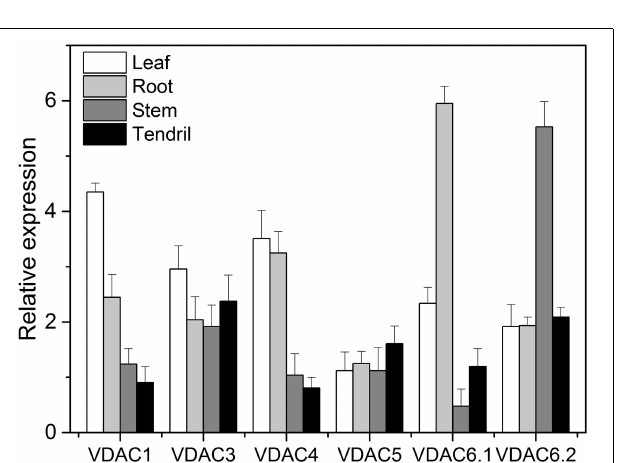
FIGURE 4 | VpVDACs expression in grape tissues. Relative VpVDAC expression in the leaves, roots, stems, and tendrils of “Liuba-8” ( V. piasezkii ). Error bars indicate the SE ( n = 3) from three independent biological replicates.